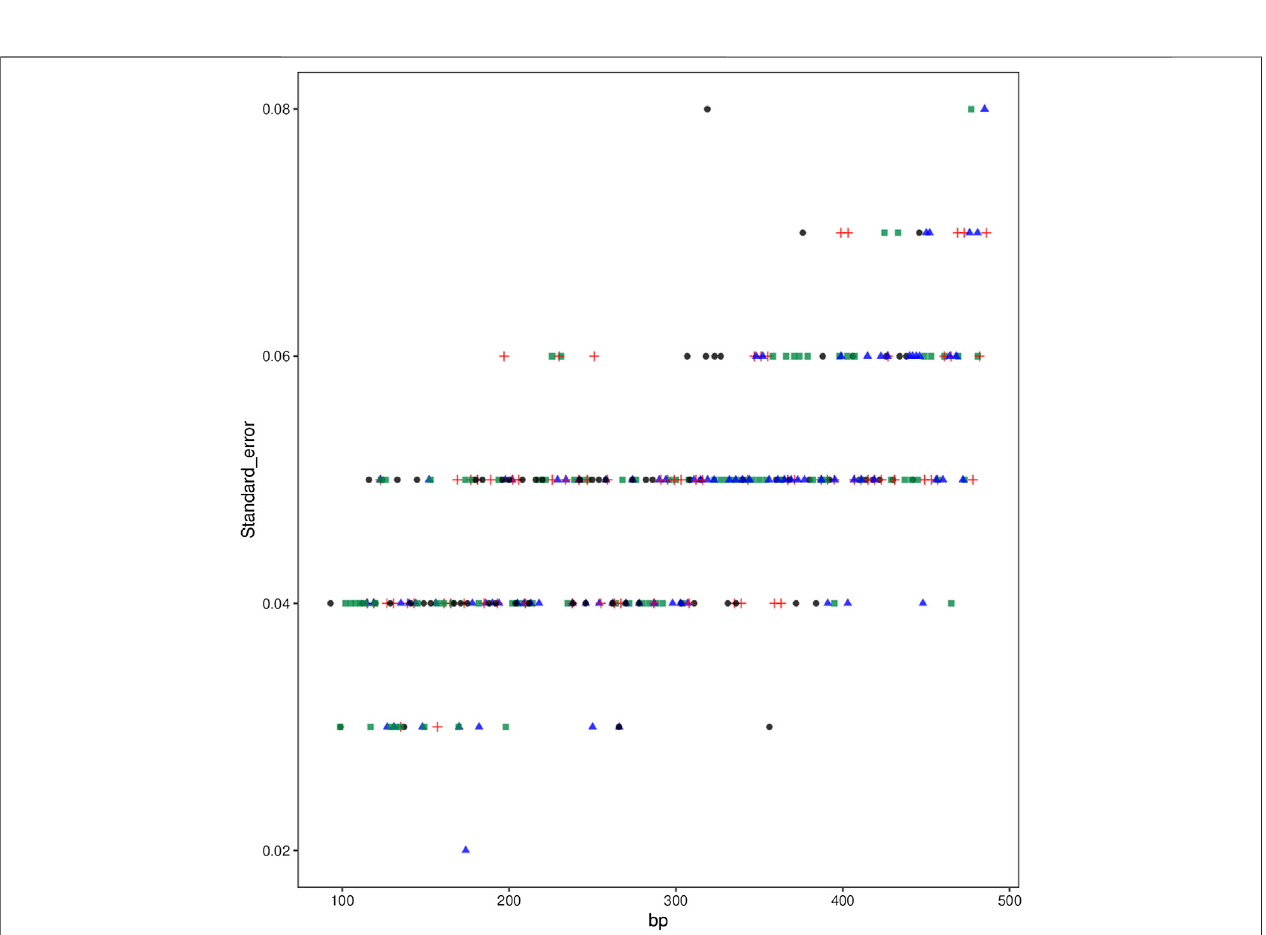
FIGURE 5 | Size precision of the STRtyper-27 comp